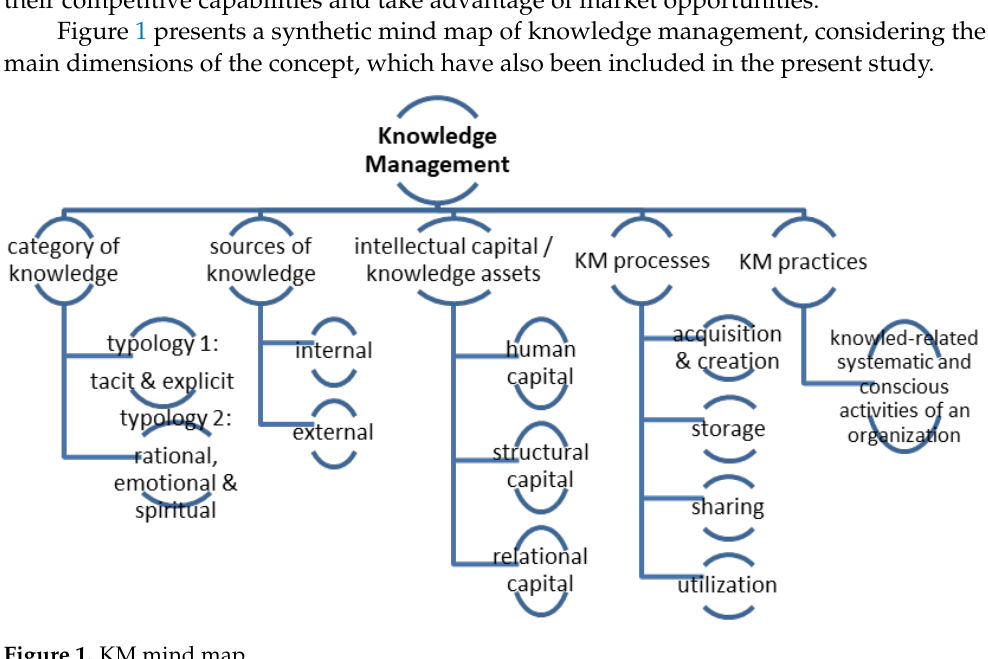
Figure 1. KM mind map.